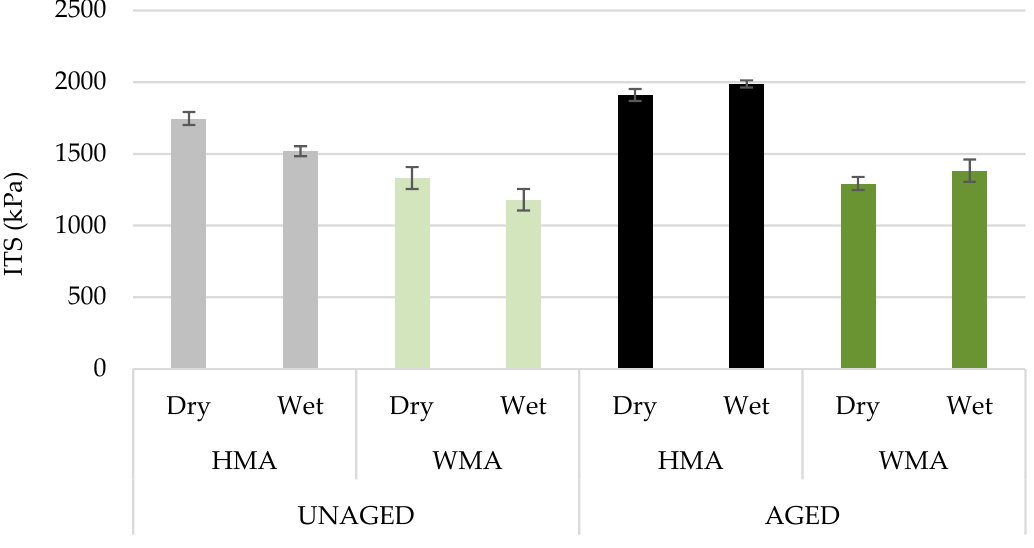
Figure 6. Results of indirect tensile strength.